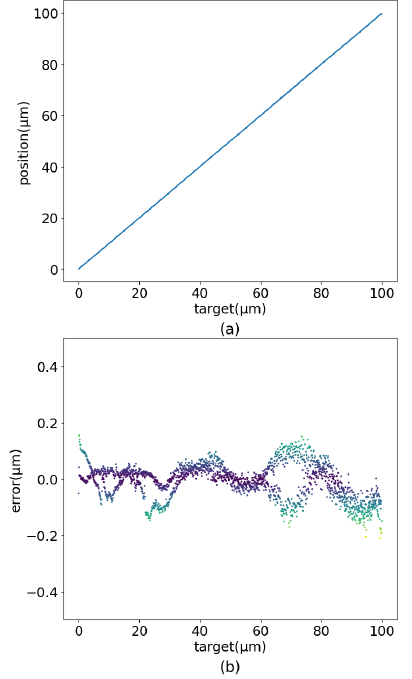
Figure 15. Linear motion control renderings. ( a ) Output. ( b )